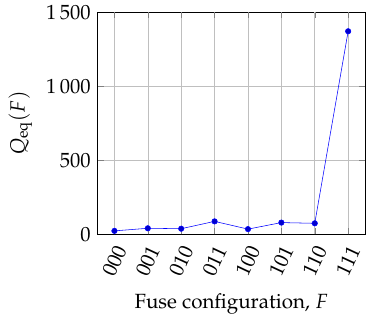
Figure 4. Equivalent Q factor, Q eq ( F ) , of a trimmable capacitor as a function of the configuration of 3 fuses with the same resistance, R f . All parameters are the same as in Figure 3a, except the specified capacitances, C and ∆ C , have both been decreased by a factor of